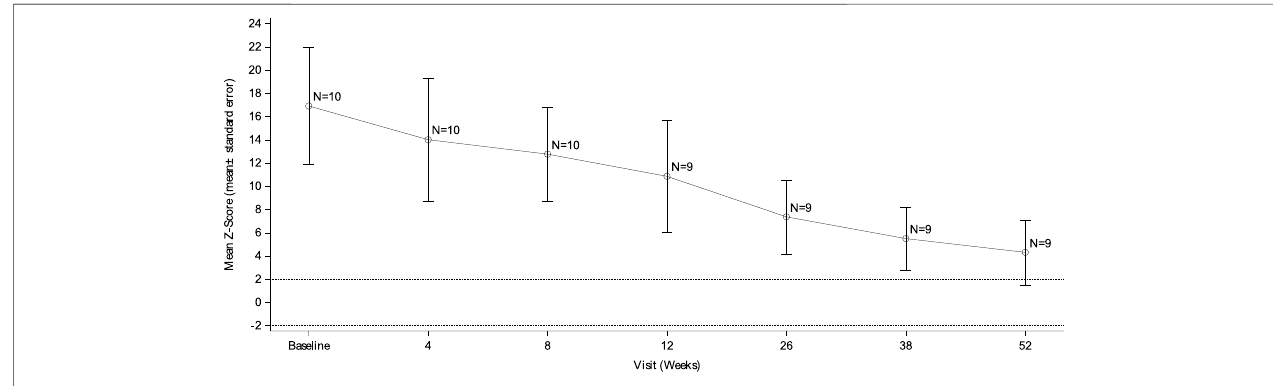
FIGURE 2 | LVM Z score changes from baseline echocardiography by visit. Data are presented as the mean ± SD. LVM: left ventricular mass.